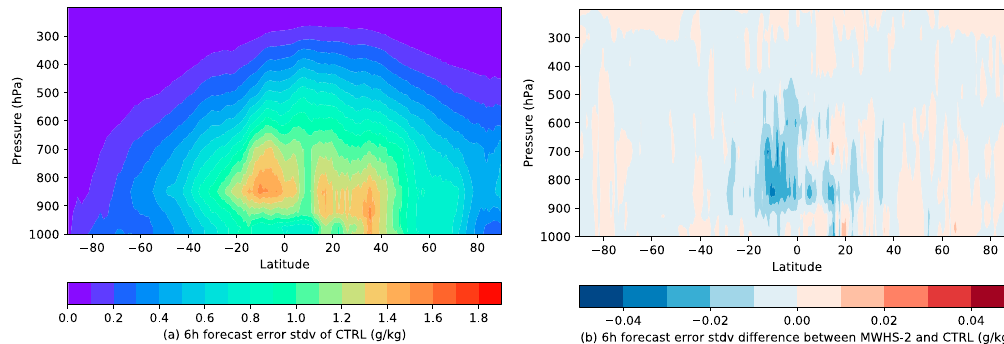
Figure 7. ( a ) Zonal ‐ mean cross ‐ section of the standard deviation of 6 ‐ h specific humidity forecasts errors against ERA5 reanalysis for the “CTRL” experiment in August 2016. ( b ) the standard deviation difference between “MWHS ‐ 2” and “CTRL”.